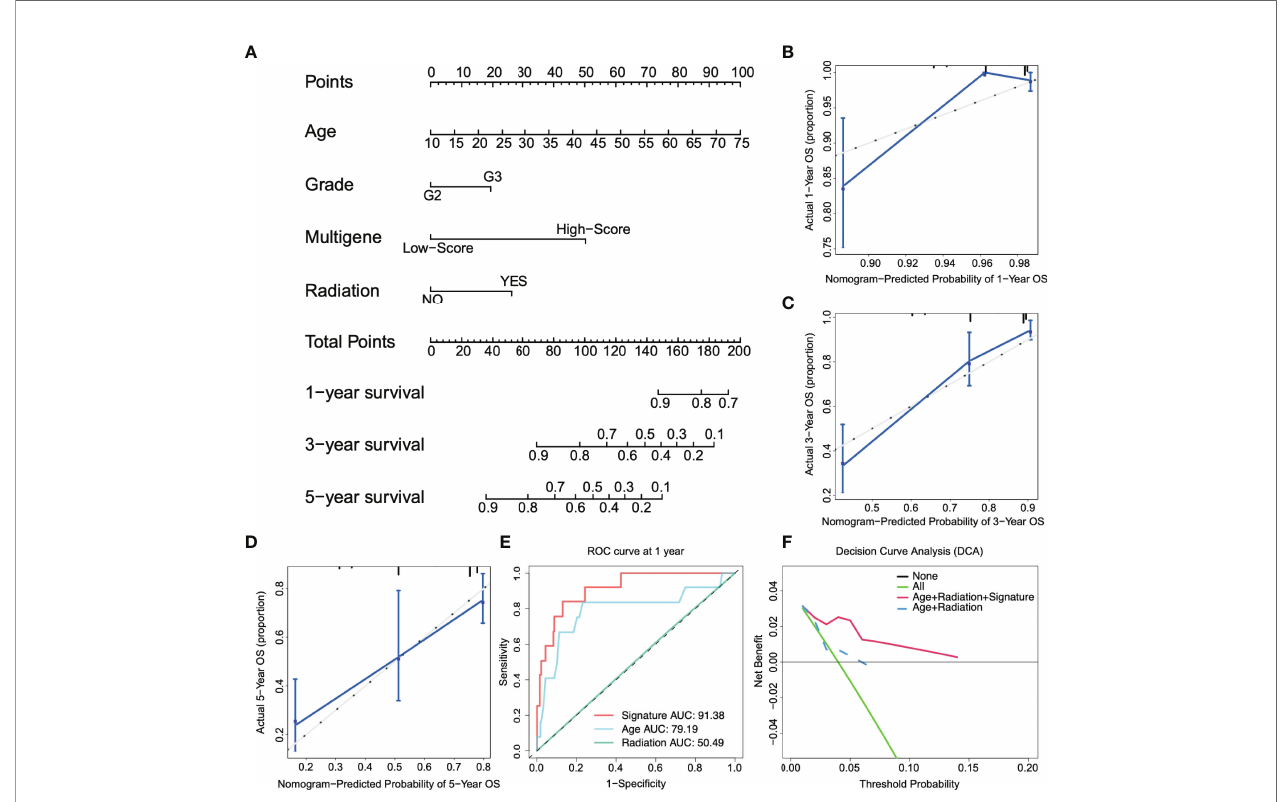
FIGURE 4 | Construction of the nomogram. (A) Nomogram predicts 1-, 3-, and 5-year OS for low-grade glioma patients based on the risk signature and other clinicopathological parameters. (B – D) The calibration curves of the nomogram for predicting and observing 1-, 3- and 5-year OS. (E) ROC curve of the risk gene signature and other parameters at one year. (F) The decision curve analysis (DCA) shows the clinical bene fi ts of patients after risk strati fi